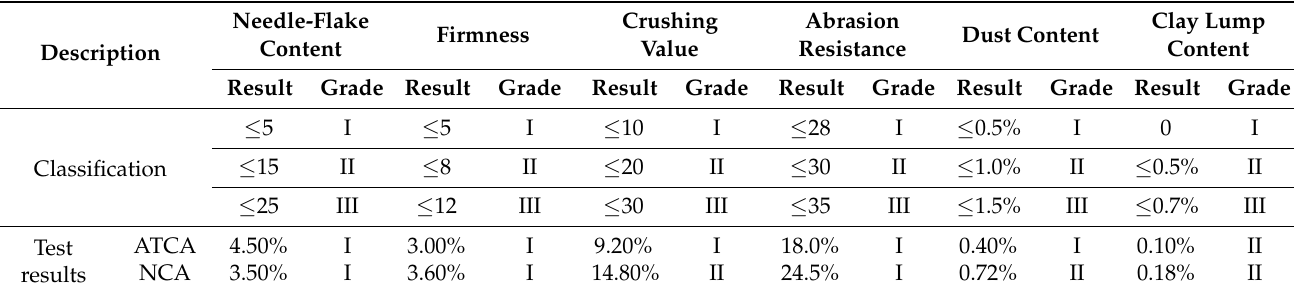
Table 3. The test results of density, water absorption and ASR.